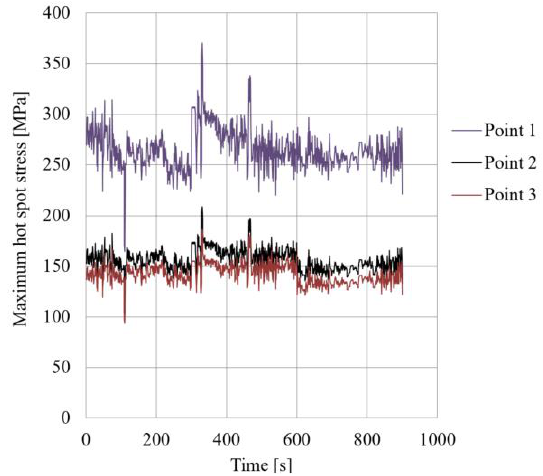
Figure 10. History of maximum hot-spot stress within the welds under dynamic load.